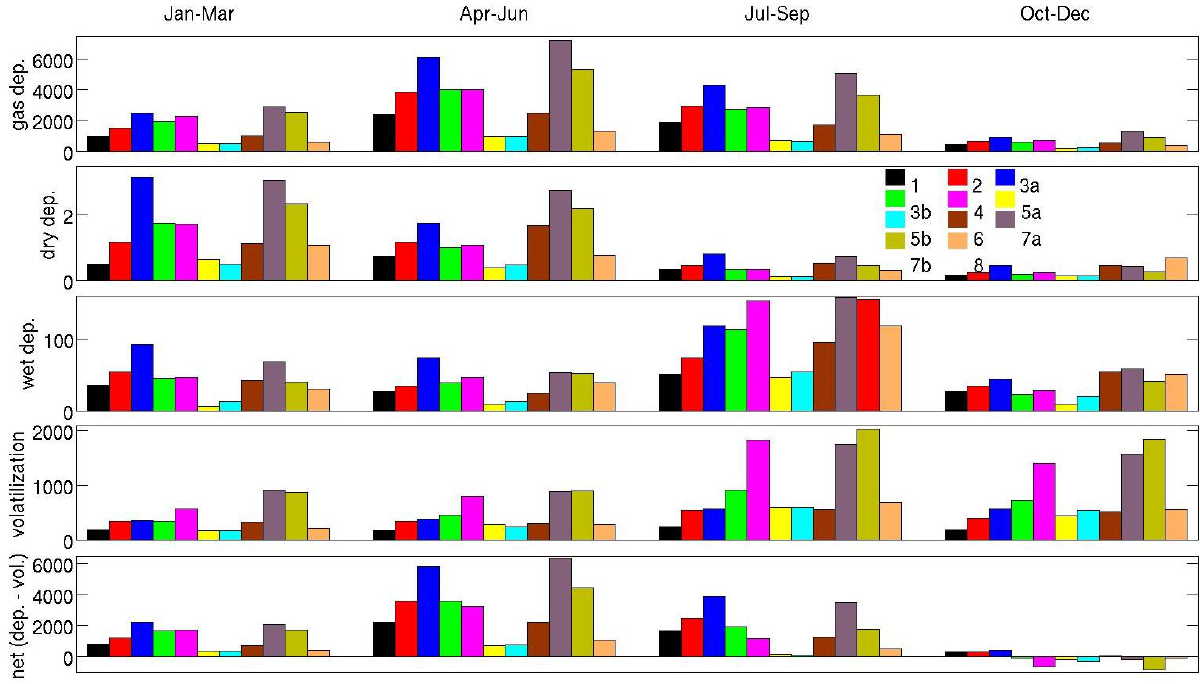
Figure 5. Bar charts of integrated quarterly (3 month) fluxes (kg) by ICES boxes (Figure 1) of γ-HCH in 1996: gas deposition ( top row ), dry deposition ( 2nd row ), wet deposition ( 3rd row ), volatilization ( 4th row ), and net air-sea exchange ( bottom row ).